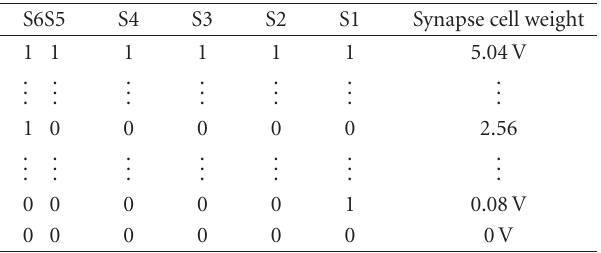
Table 2: Example of synapse weight